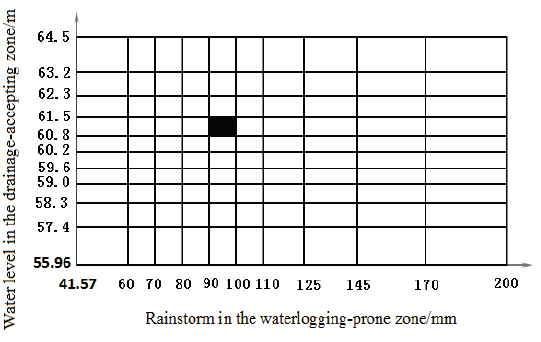
Fig. 3 The map of division of integral